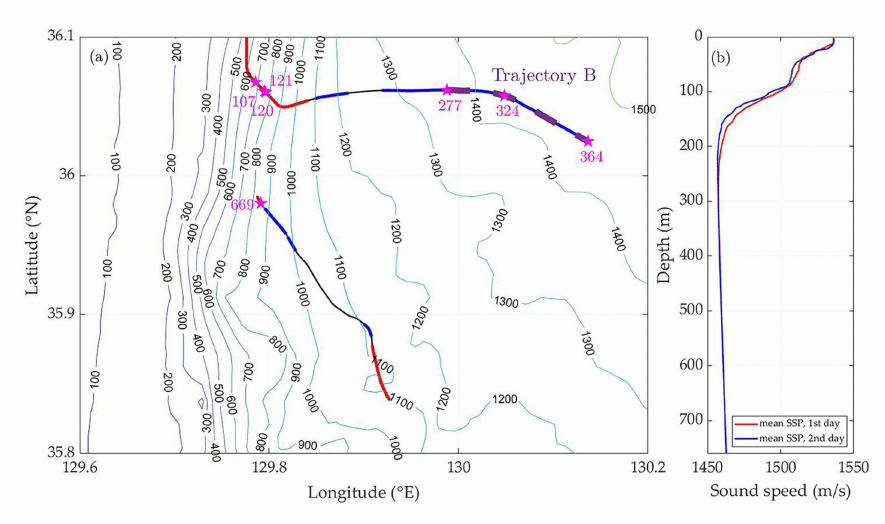
Figure 2. Sea trial environment for the measurement of ocean reverberation in the East Sea, Korea. ( a ) Trajectory of the research vessel at the experimental site. The symbols of red circles and blue crosses indicate the positions where the CW pings and the LFM pings are launched, respectively. The pentagram symbols and the “Trajectory B” denote the positions of the pings used for the analysis. ( b ) Mean sound speed profiles of the first and second